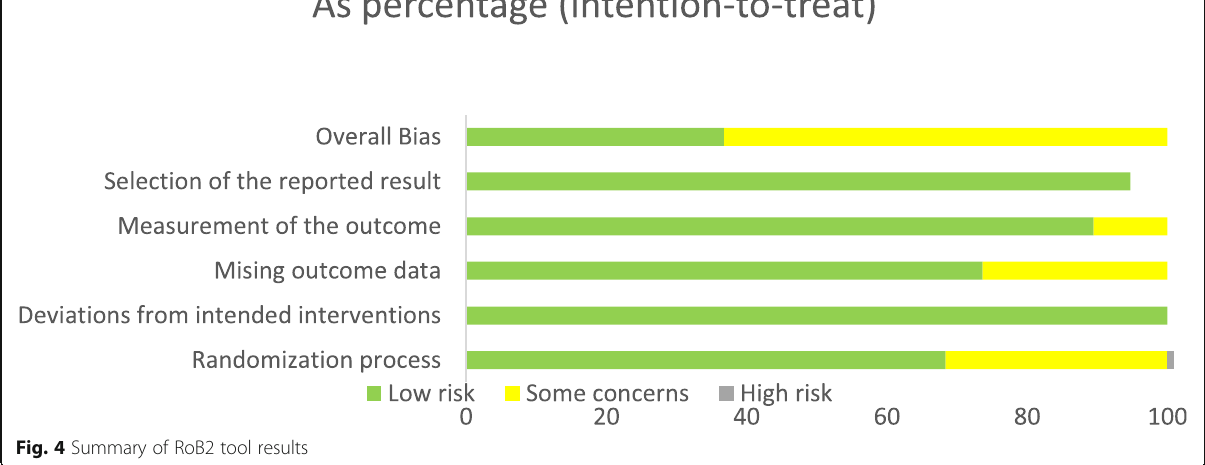
Fig. 4 Summary of RoB2 tool